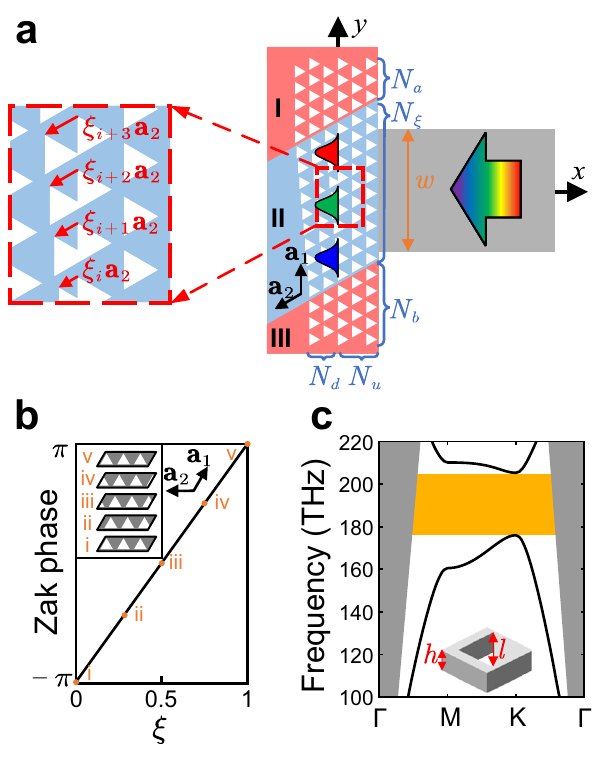
Fig. 1 Geometric structure, bulk bands, and Zak phase. a Schematic diagram of the topological rainbow con fi guration. a 1 , a 2 denote the lattice vectors. The red and blue regions denote the barrier and dispersing regions, respectively. The displacement vector of i th layer is denoted by ξ i a 2 . N a , N ξ , N b denote the number of layers of regions I, III along a N u , N d 1 direction, and denote the number of layers of undeformed region and the deformed region in region II. Light is incident from the dielectric waveguide with a width w = 8 μ m. b Evolution of Zak phases with parameter ξ . The inset shows the geometric structure for different ξ s. c The TE-like bands of triangular hole structure with side length l = 0.75 a and thickness h = 220 nm. The geometry of the unit cell is shown in the